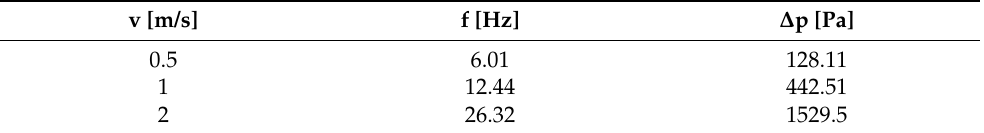
Table 1. Computational results for the vortex shedder from the Figure 2.